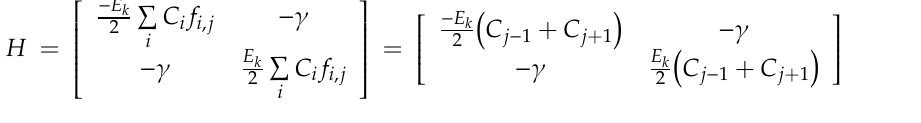
Figure 14. Area comparison of QCA 4 × 4 multipliers.